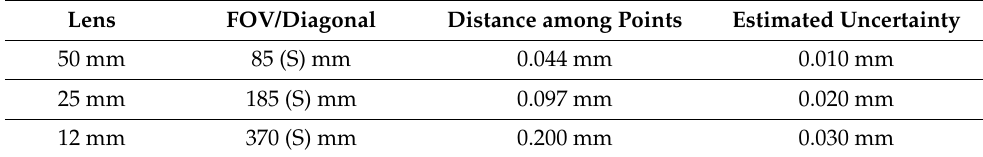
Table 2. Identification of the different lenses